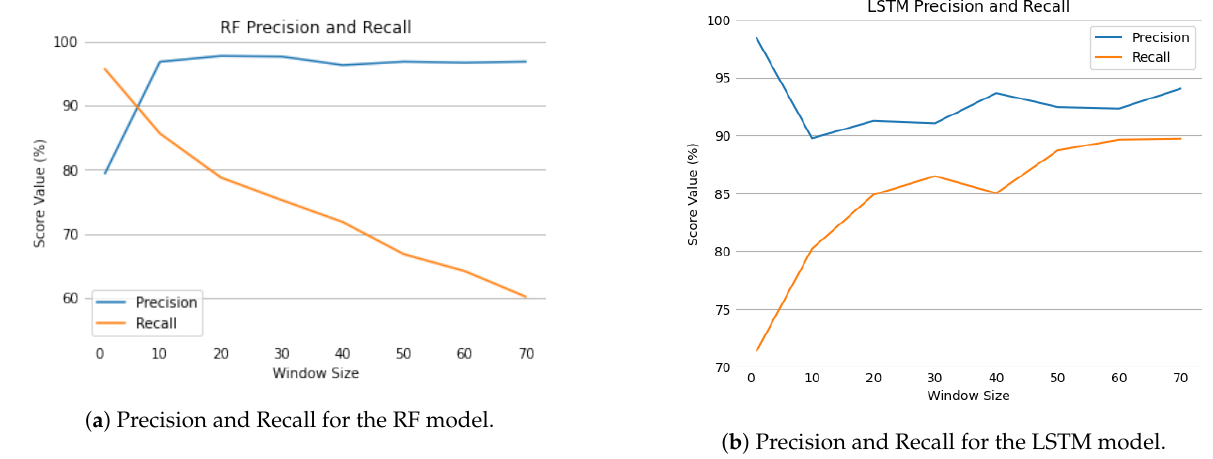
Figure 10. Precision and recall values for the RF and LSTM models as window size